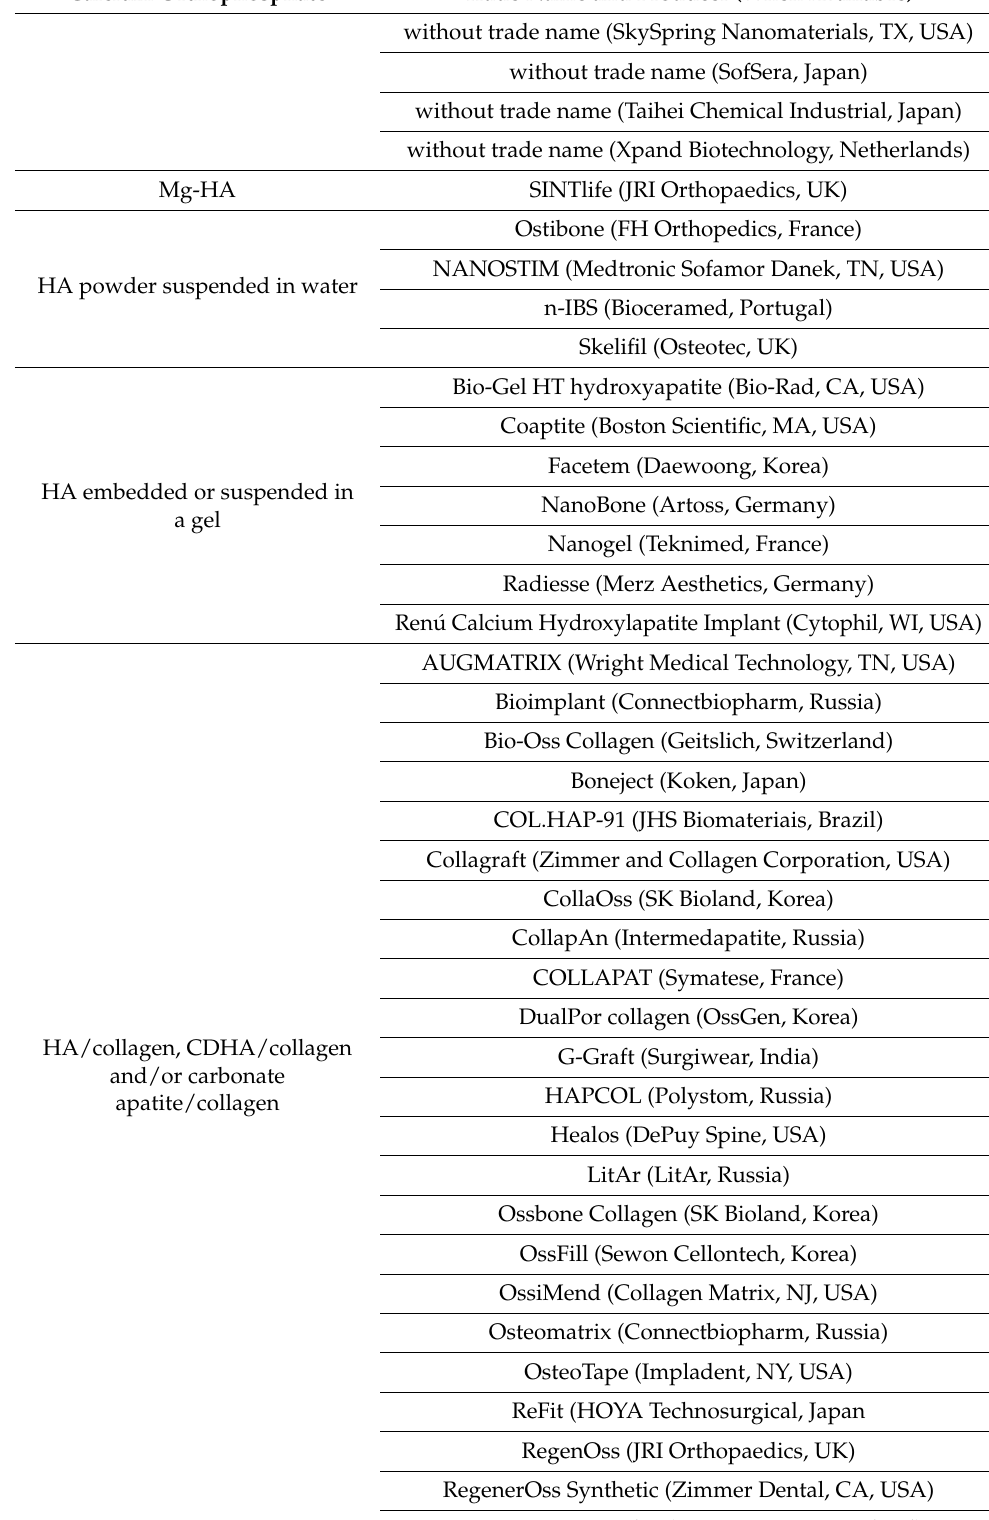
Table 3. Cont . Calcium Orthophosphate Trade Name and Producer (When